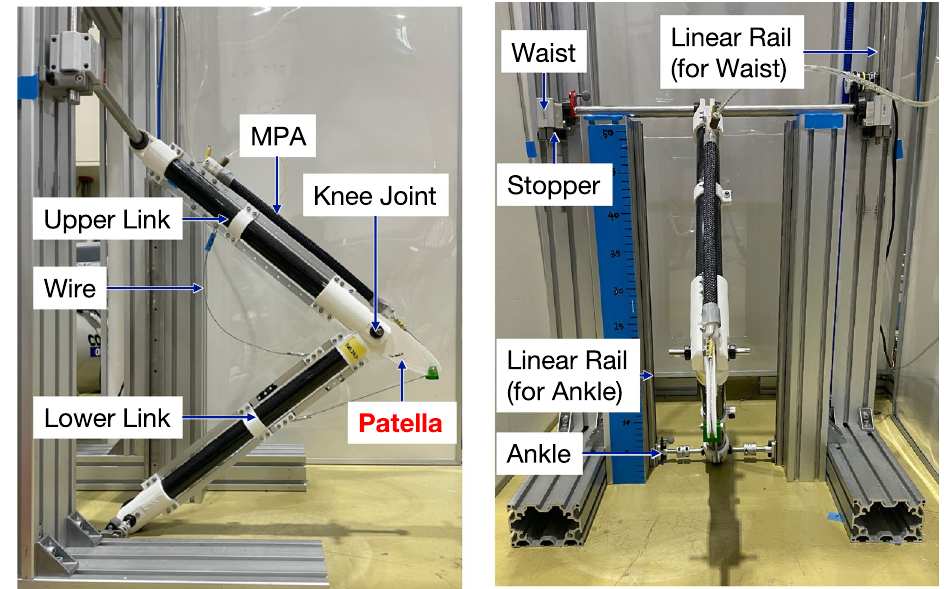
Fig. 12 Overview of the developed leg-type robot and its